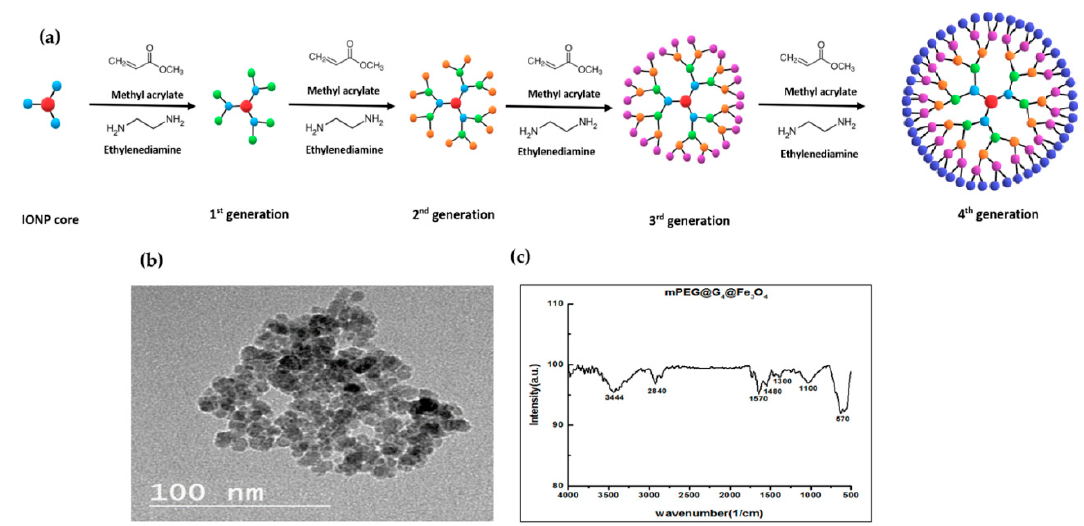
Figure 2. ( a ) Schematic illustration of functionalization of iron oxide magnetic nanoparticles (IONPs) with G4 poly amidoamine (PAMAM) dendrimers, ( b ) transmission electron microscope (TEM) image of G 4 @IONPs, ( c ) Fourier-transform infrared spectroscopy (FTIR) spectra for PEGylated G 4 @IONPs.